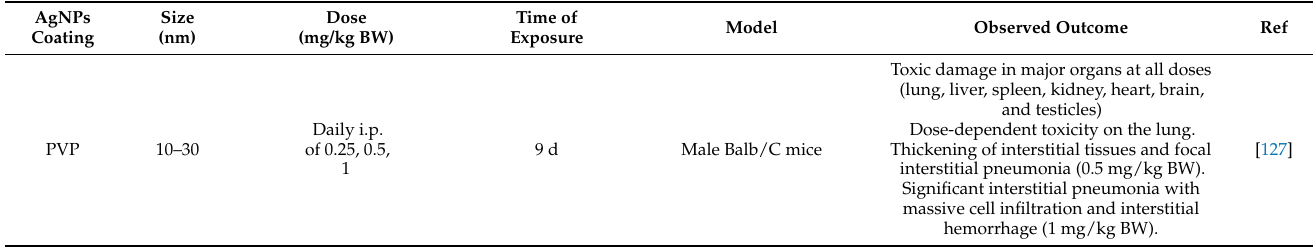
Table 2. Observed outcomes after in vivo administration of several AgNP formulations by different administration